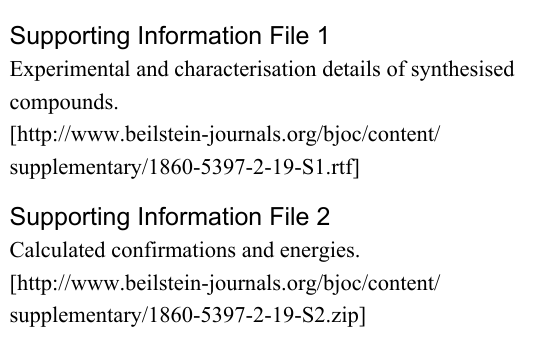
1,2-difluoro-1,2-diphenylethanes isomers 13 are different in the series and do not conform to the ratios described